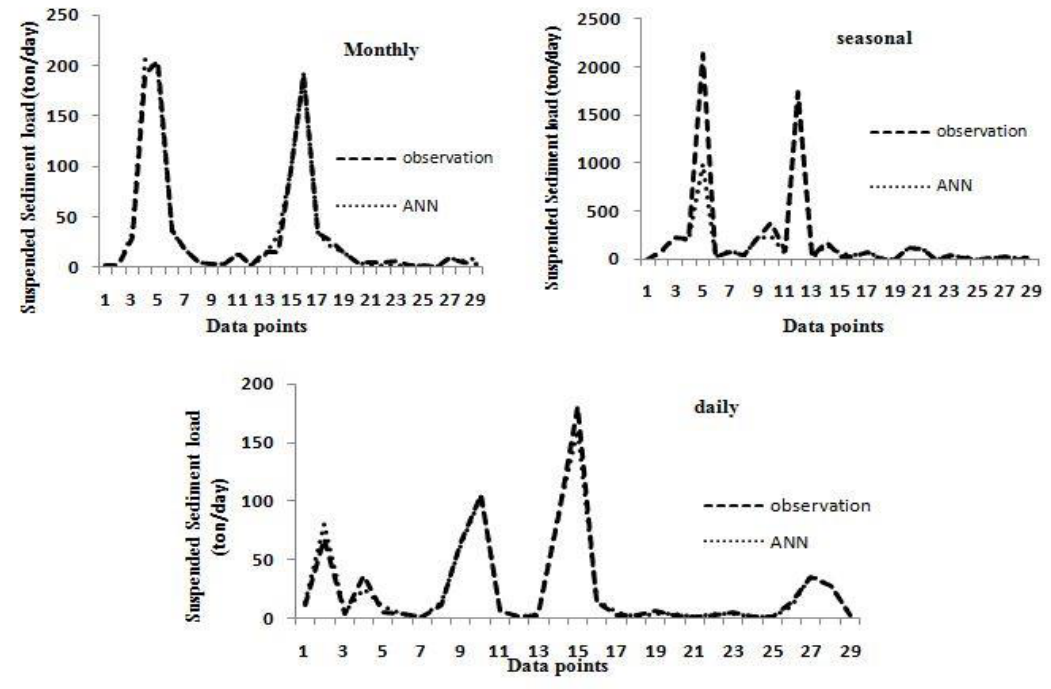
Fig. 2. Comparison of ANN model with observational sediment